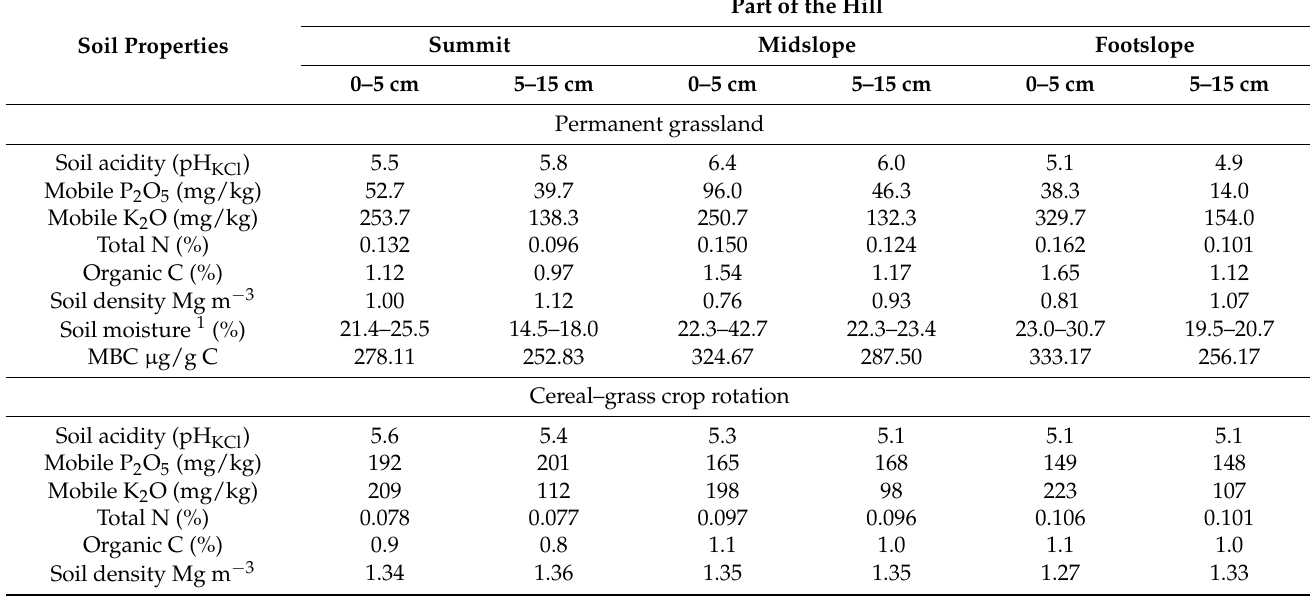
Table 1. Agrochemical, physical and biological properties of the arable (0–15 cm) soil depth